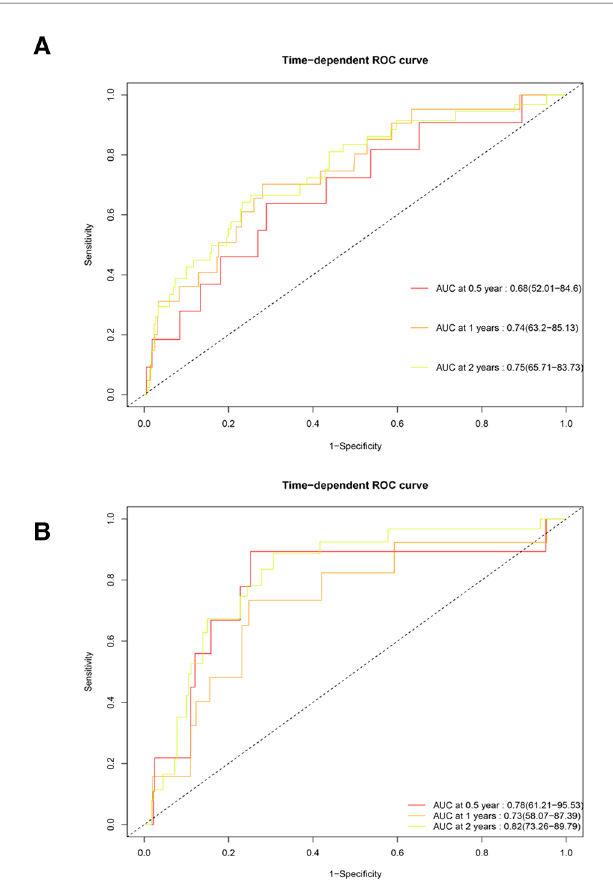
FIGURE 5 Time-dependent receiver operating characteristic curve of the training and testing groups. ( A ) Training group. ( B ) Testing group. The horizontal axis represents speci fi city, and the vertical axis represents sensitivity. AUC, area under the